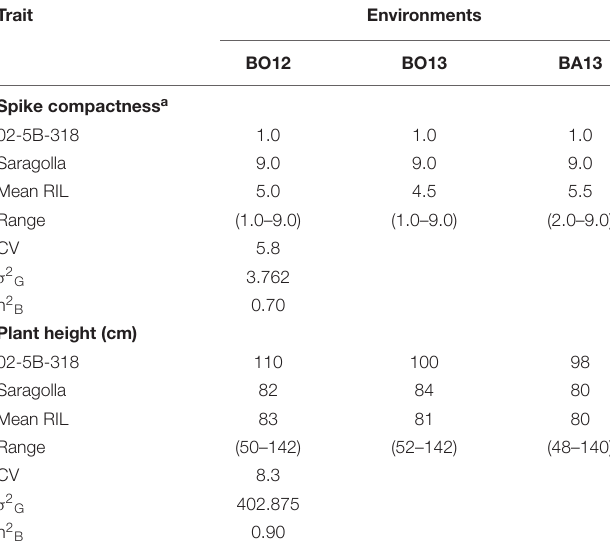
TABLE 2 | Mean, range, genetic variance ( σ 2 G ), and heritability (h 2 B ) estimates for spike compactness and plant height in the RIL population derived from crossing FHB-resistant 02-5B-318 line and FHB-susceptible cv. Saragolla, evaluated in three environments (Bologna 2012, Bologna 2013, Bari